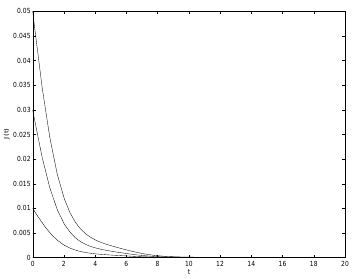
Figure 6. Trajectories of I(t) for dif- ferent initial conditions.